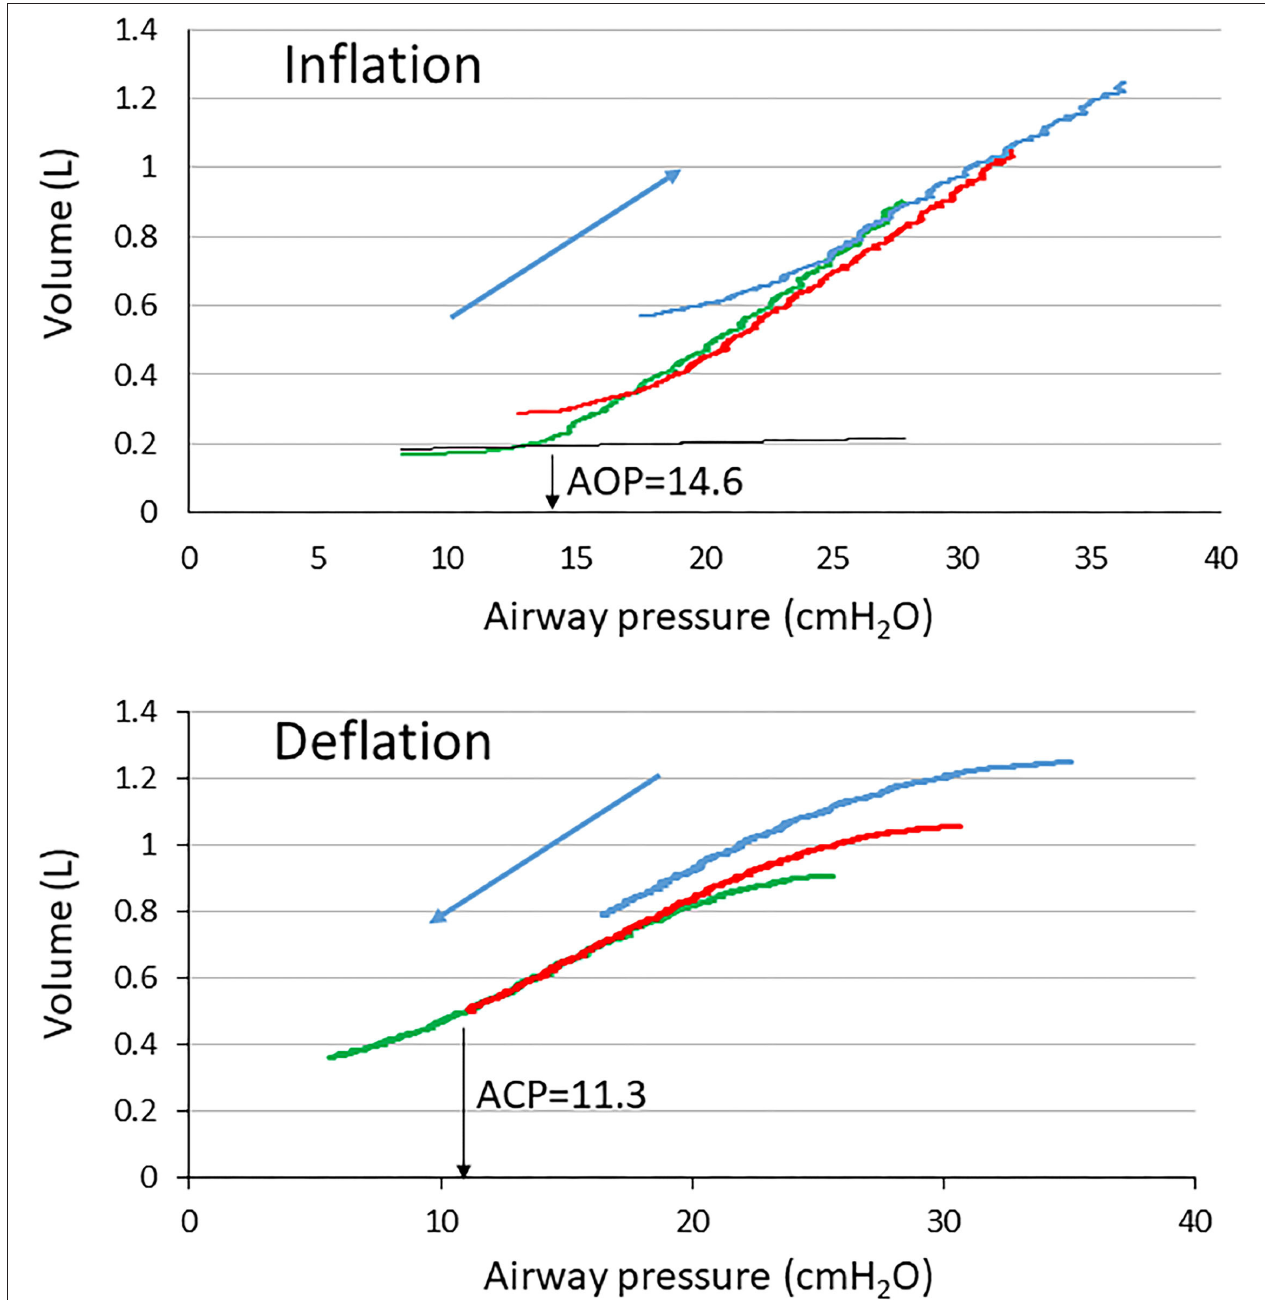
FIGURE 4 | Volume-Pressure curves of the respiratory system at PEEP of 5 (green), 10 (red), and 15 (blue) cmH 2 O in a patient with ARDS with EFL. The black broken curve is the curve of the ventilator tubing used to define airway opening pressure (down black arrow AOP) at PEEP 5. ACP, airway closing pressure (down black arrow